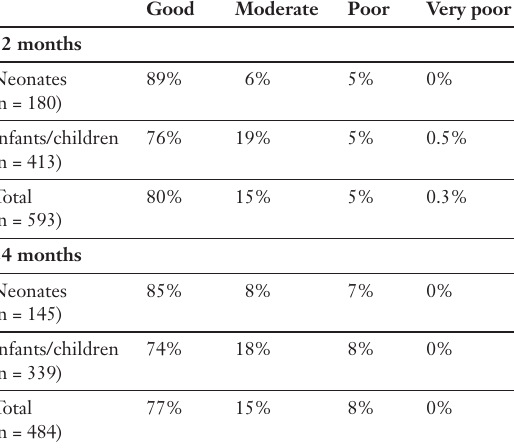
Outcome groups 12 and 24 months after PICU discharge (including all deaths after discharge).